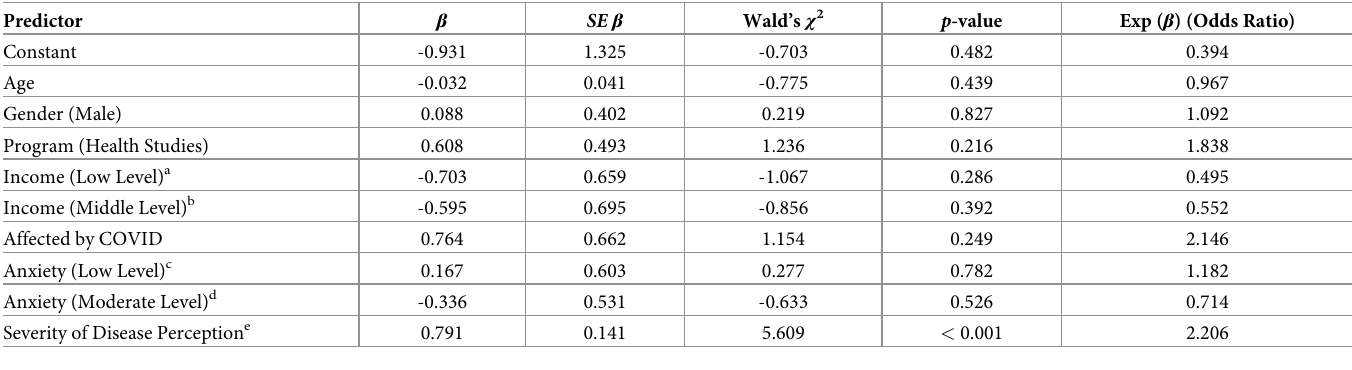
Table 4. Multinomial logistic regression